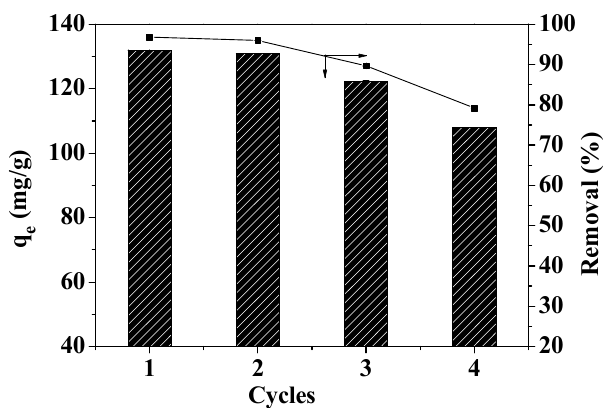
Figure 14. Reusability of MOF-5–CMC beads for the adsorption of Pb(II).